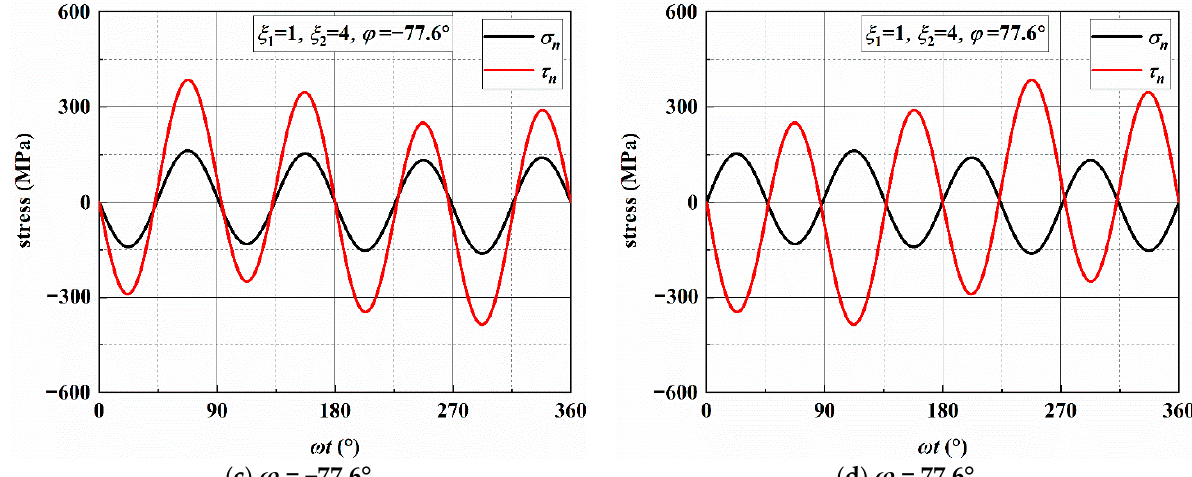
Figure A3. Variation of normal and shear stress on MSSA plane under AS-4.